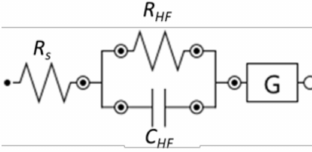
Figure 7. The equivalent electrical circuit that has been used to fit the data obtained from EIS